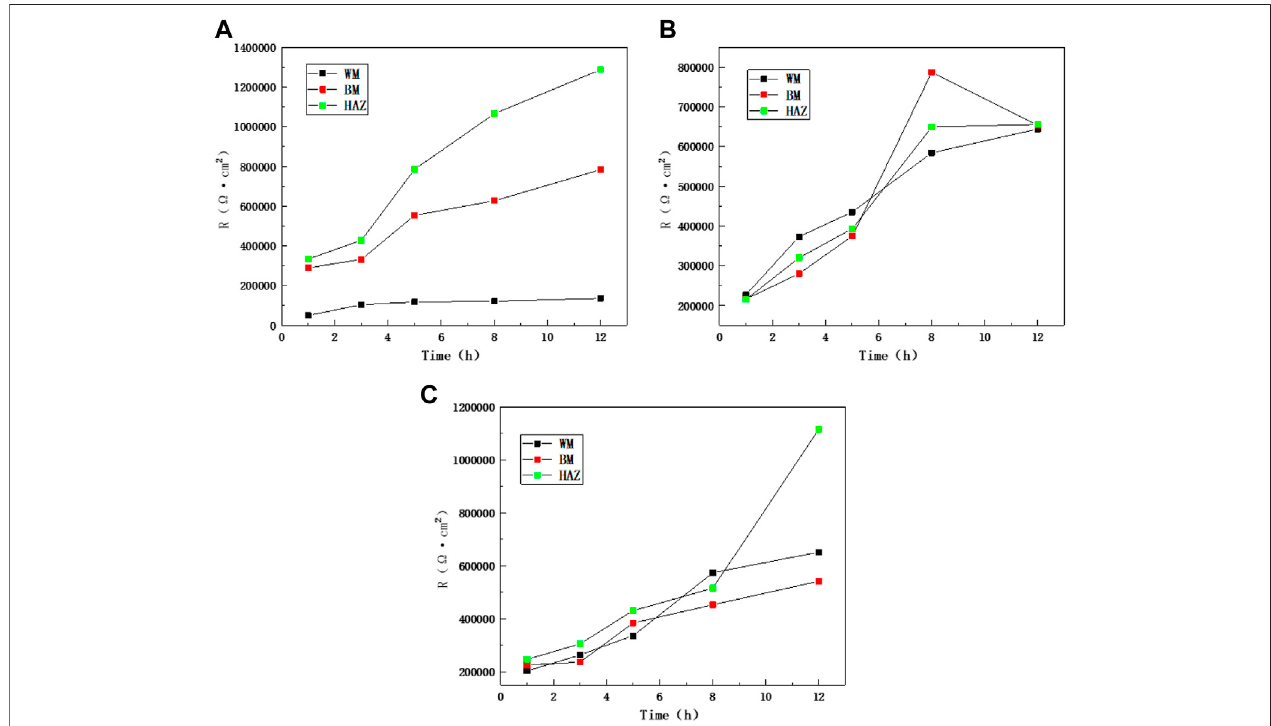
FIGURE 10 | Impedance comparison between zones at different fl ow rates: (A) 1.85 m/s, (B) 3 m/s, and (C) 6 m/s.